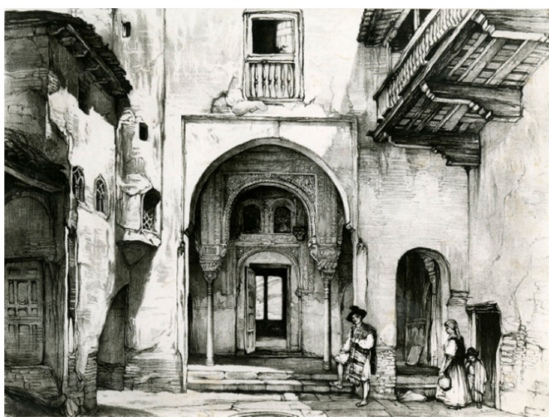
Figure 19. North wall of the court of the Cuarto Dorado with architectural elements from the 15th and 16th centuries. Drawing by John Frederick Lewis (1833–1834). © Archivo del Patronato de la Alhambra y Generalife, Photograph Collection, F-006625.